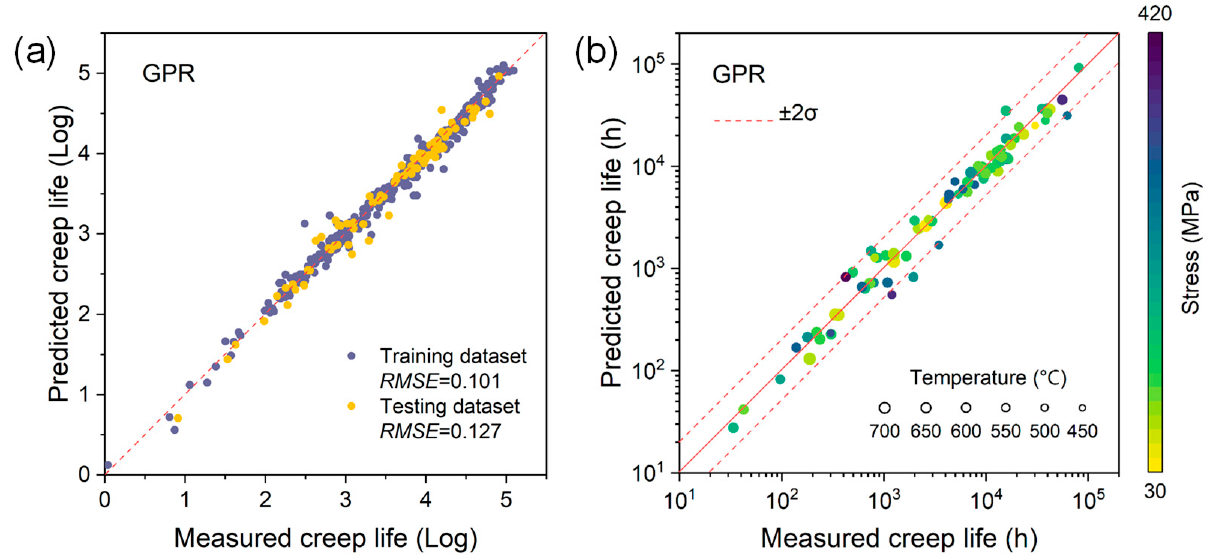
Figure 7. Prediction results of creep rupture life by GPR model: ( a ) Training and prediction results of creep life in log scale; ( b ) Predicted creep life vs. measured creep life.